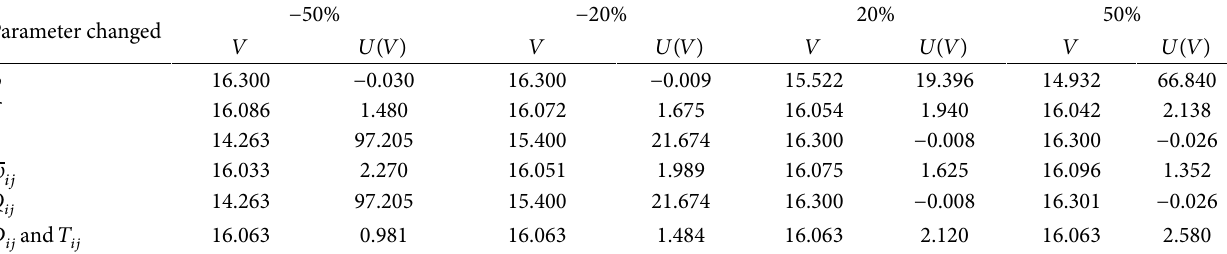
Figure 4: Sensitivity analysis using different weights of the value functions. Table 5: Sensitivity analysis on other